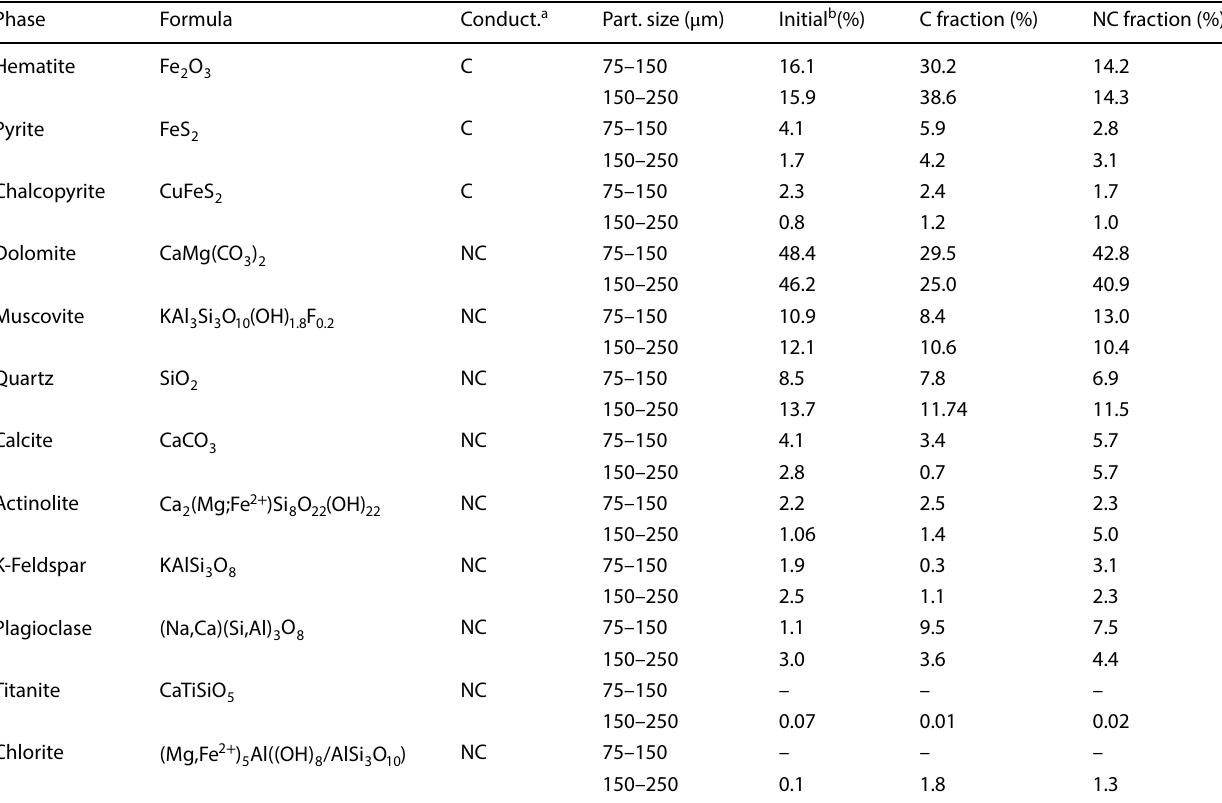
Table 3 Conductivity of the minerals found in sample PE-02 with XRD and concentration of the conductor and non-conductor fraction of sample PE-02 after electric